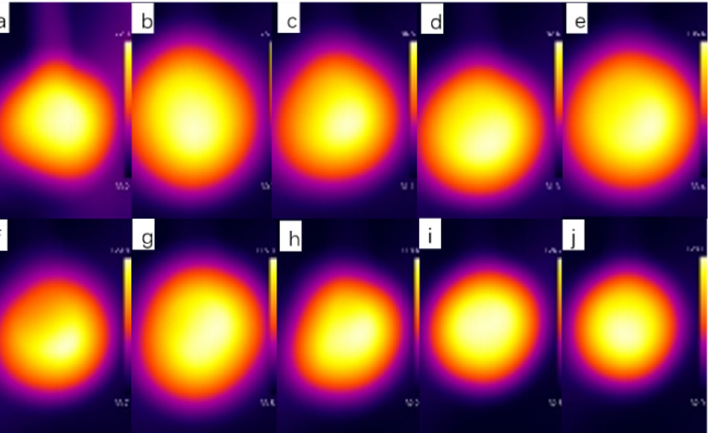
Figure 11. Infrared images of the GO-TPU films with loadings of GO via IR light pure TPU ( a ), 0.1 wt % ( b ), 0.3 wt % ( c ), 0.6 wt % ( d ), 1 wt % ( e ), 2 wt % ( f ), 3 wt % ( g ), 4 wt % ( h ), 5 wt % ( i ), and 7 wt % ( j ), respectively.